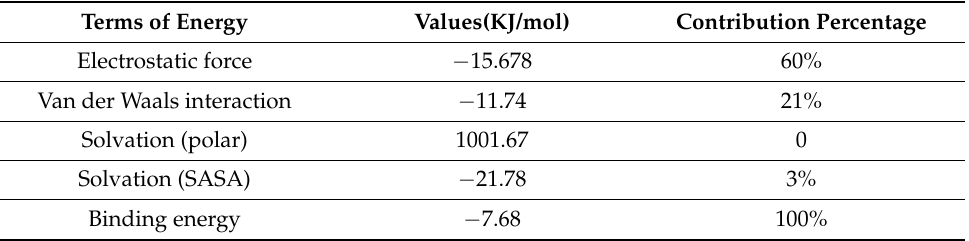
Table 10. Prediction of energy terms, values, and contribution percentages calculated by MM/PBSA